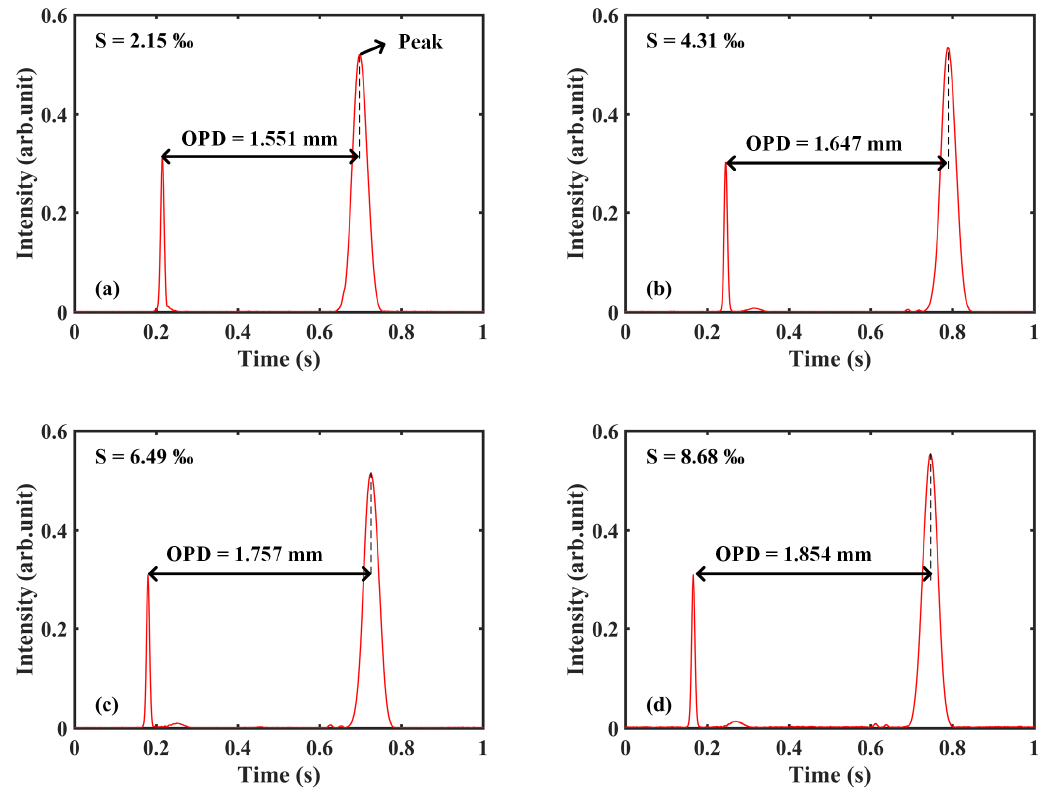
Figure 10. ( a ) Results of the Hilbert transform in 2.15‰; ( b ) results of the Hilbert transform in 4.31‰; ( c ) results of the Hilbert transform in 6.49‰; ( d ) results of the Hilbert transform in 8.68‰.